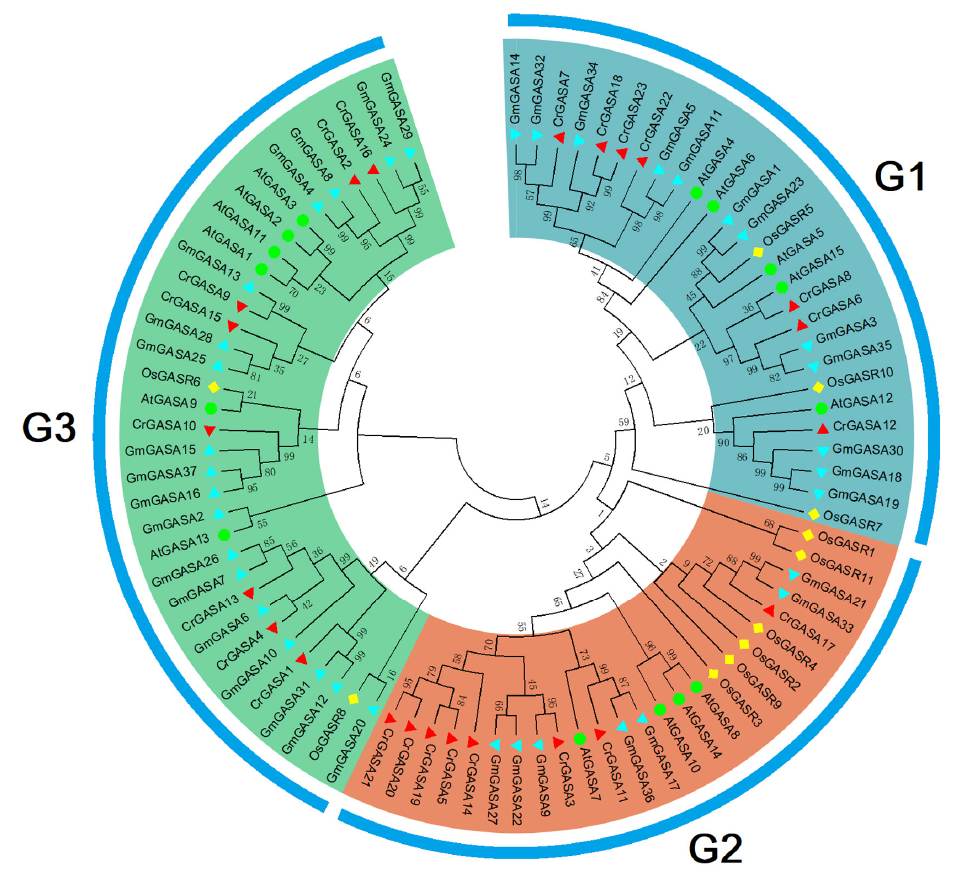
Figure 2. Phylogenetic relationships of the twenty-three CrGASAs from C. rosea , fifteen AtGASAs from Arabidopsis thaliana , eleven OsGASRs from Oryza sativa , and thirty-seven GmGASAs from Glycine max . These eighty-six amino acid sequences of four plant species were compared with ClustalW alignment, and the phylogenetic tree was constructed in MEGA 6.0 using the neighbor-joining method, with 1000 bootstrap repetitions. The different branch colors represent different groups, including G1 (cyan), G2 (brown), and G3 (green).